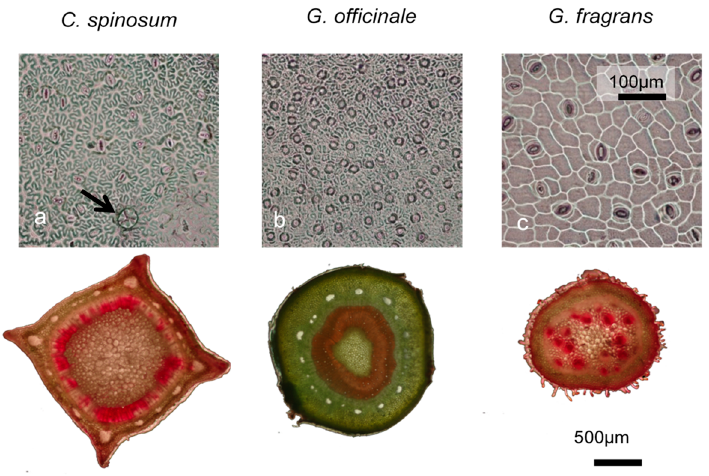
Figure 6. Imprints of the abaxial side of leaves of C. spinosum ( a ), G. officinale ( b ) and G. fragrans ( c ) showing density and size of stomata. Wood cross section after phloxine treatment showing the fraction of functional xylem vessels coloured in red; C. spinosum is the only species to possess trichomes (arrow). G. officinale had the smallest stomata, the highest stomatal density and the greatest stem cross section devoted to water transport.